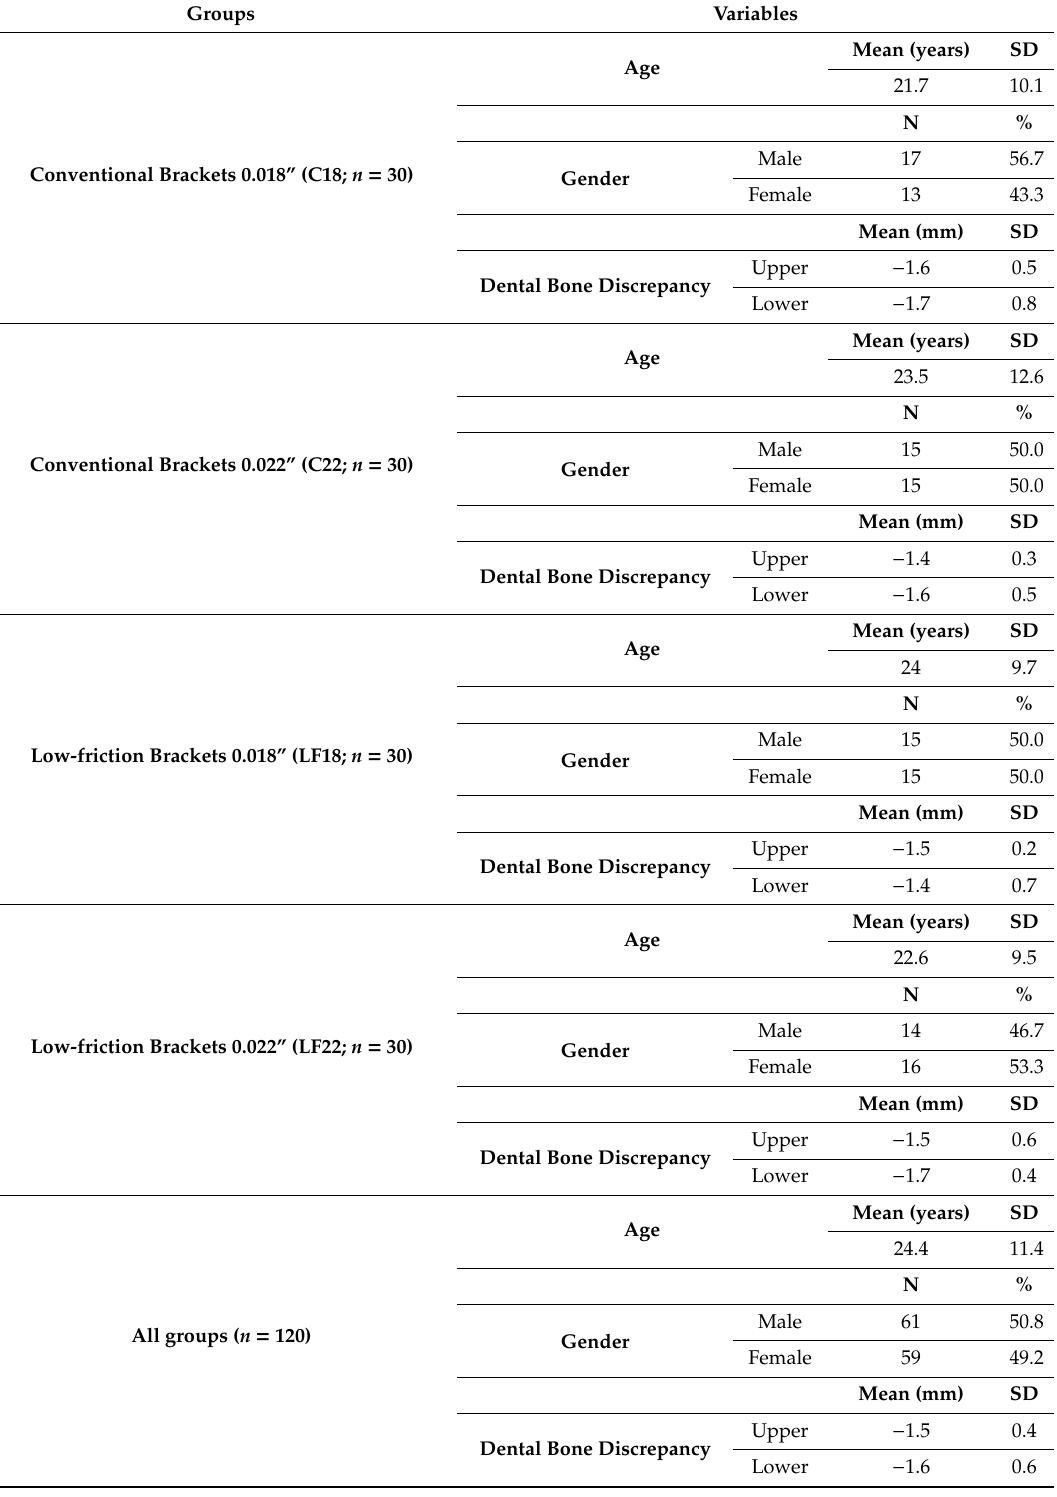
Table 1. Descriptive data of the sample divided by groups ( n =